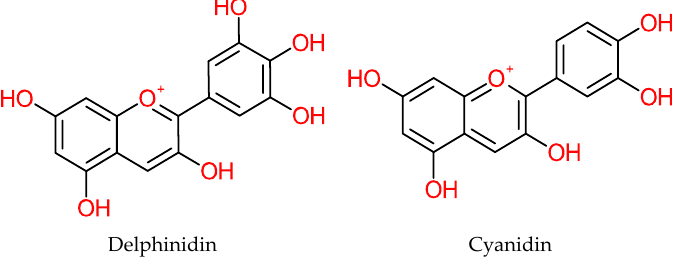
Figure 19. Terpenoids.